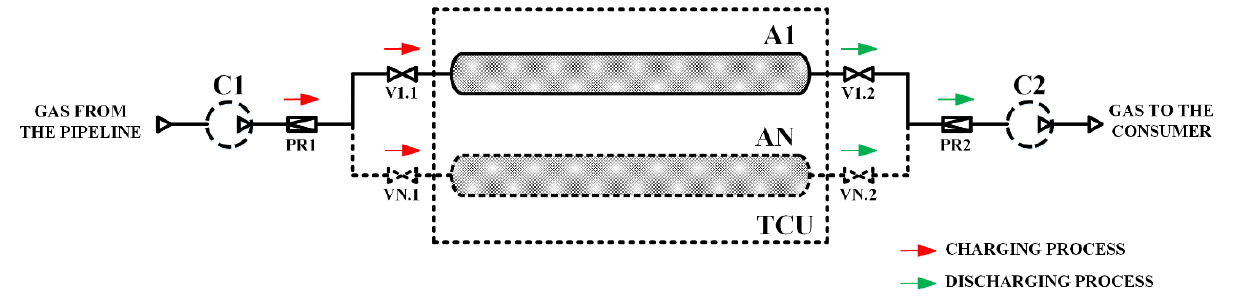
Figure 1. Scheme of the adsorption storage. C1, C2 –natural gas compressors; A1…AN– ANG storage systems (adsorption tanks); TCU –thermal control unit; V1.1…VN.1 and V1.2…VN.2– stop valves; PR1-2 – pressure regulators.